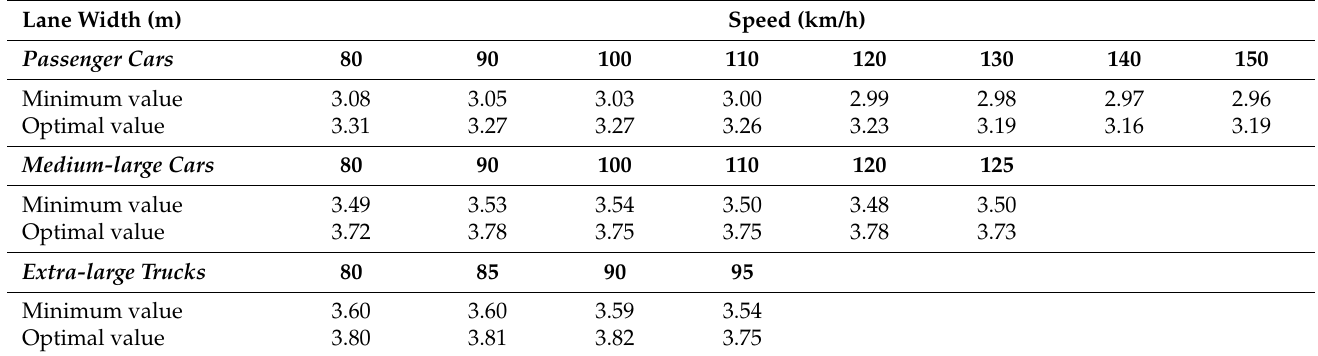
Table 7. Theoretical minimum and optimum values of lane width for different